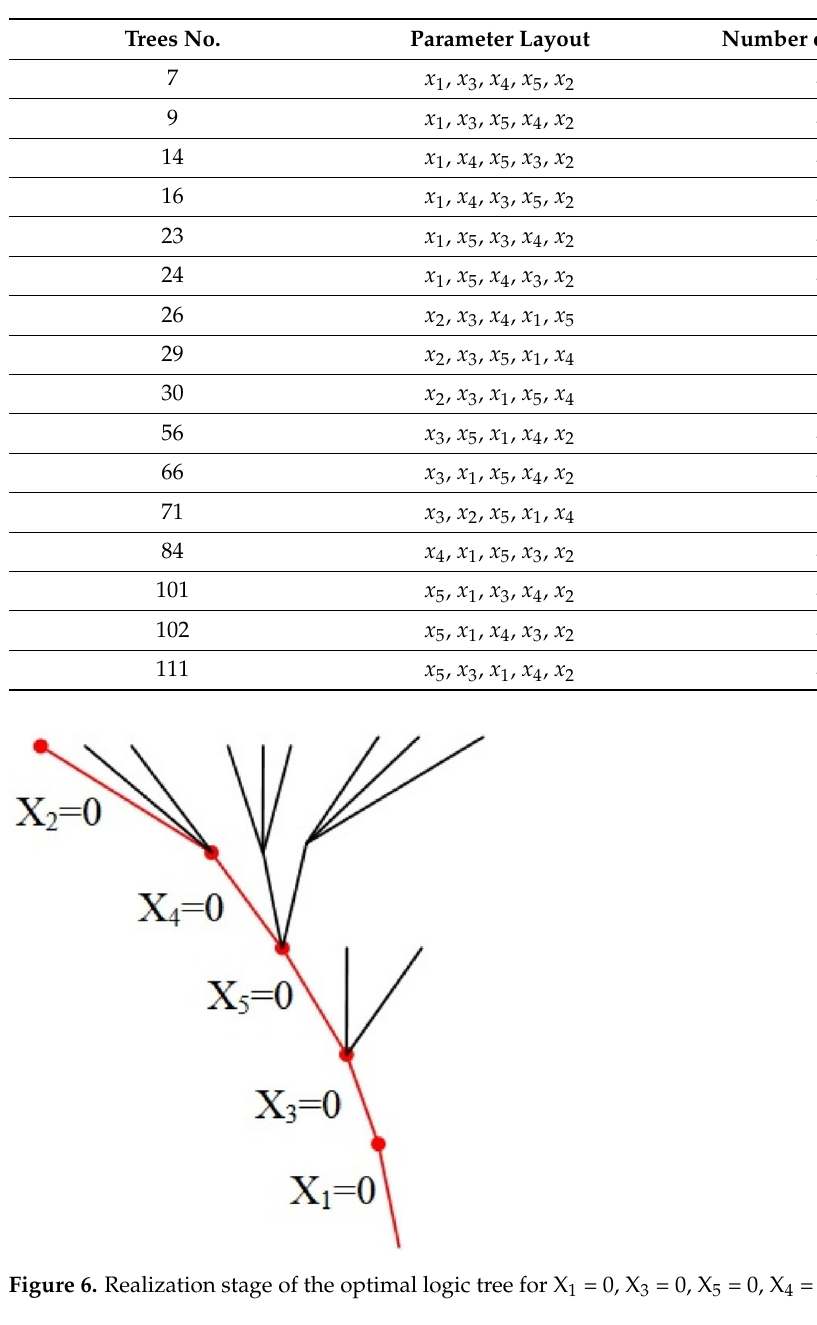
Table 3. Summary of decision variable systems with the number of true branches.